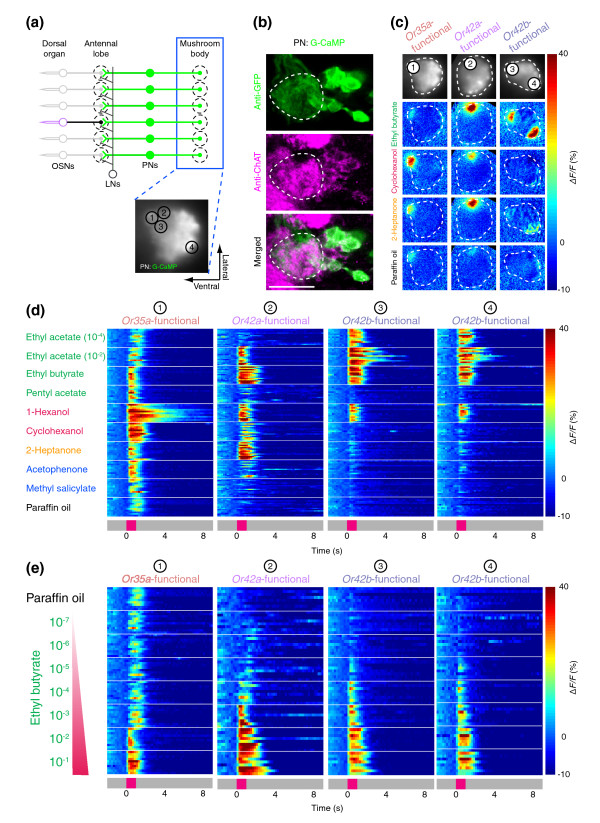
Odor responses of larval projection neurons. (a) Schematic for measuring functional activation of larval PNs in Or35a-, Or42a-, or Or42b-functional larvae at axon terminals in the mushroom body (blue box). Intrinsic G-CaMP fluorescence of the mushroom body, with subdomains 1–4 and sample orientation indicated (bottom). (b) Confocal image (flattened z-stack of 2 × 1.2 μm optical slices) of PN cell bodies stained to reveal G-CaMP (anti-GFP antibody, green) and Drosophila choline acetyltransferase (anti-ChAT, magenta). Scale bar = 20 μm. (c) Representative G-CaMP activity in PN terminals in mushroom body elicited by three odorants (10-2 dilution) and paraffin oil (solvent) in (left to right): Or35a-, Or42a-, and Or42b-functional larvae. Top row shows intrinsic mushroom body G-CaMP fluorescence and bottom four rows show false color-coded image of mushroom body taken 600 ms after stimulus onset, and represented as %ΔF/F (scale at the right). (d) Responses of PNs of single-functional larvae in (b) to eight odorants (10-2 dilution except as indicated) and paraffin oil (solvent) represented as false color-coded time traces (%ΔF/F; scale at bottom right). Traces from n = 11–14 animals per stimulus are stacked. Region of analysis is from major subdomain 1–4, as indicated in (a-b). (e) Responses of major subdomains 1–4 of PN axon termini in mushroom body of Or35a-, Or42a-, and Or42b-functional larvae to an ethyl butyrate concentration series and paraffin oil (solvent) represented as ΔF/F (%) (scale at right). Traces from n = 8 animals per genotype and stimulus are stacked.